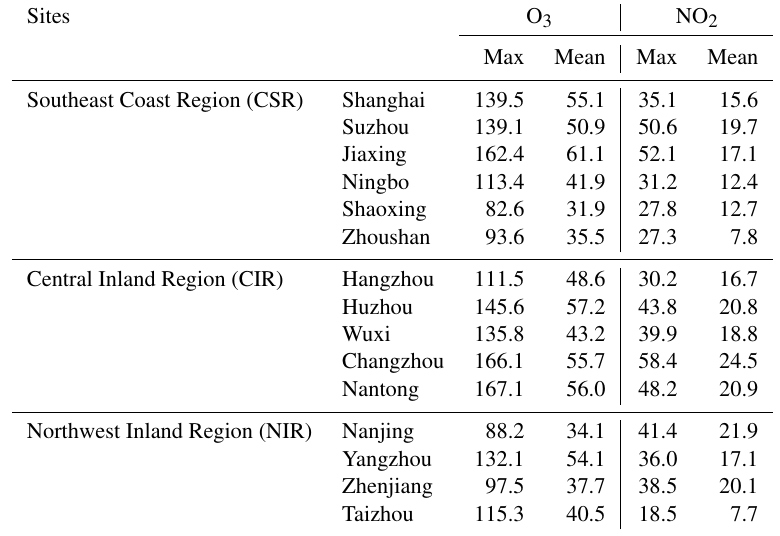
Table 2. The maximum and average concentrations of O 3 and NO 2 observed in 15 cities during 7–12 August 2013 (ppb). Sites O 3 NO 2 Max Mean Southeast Coast Region